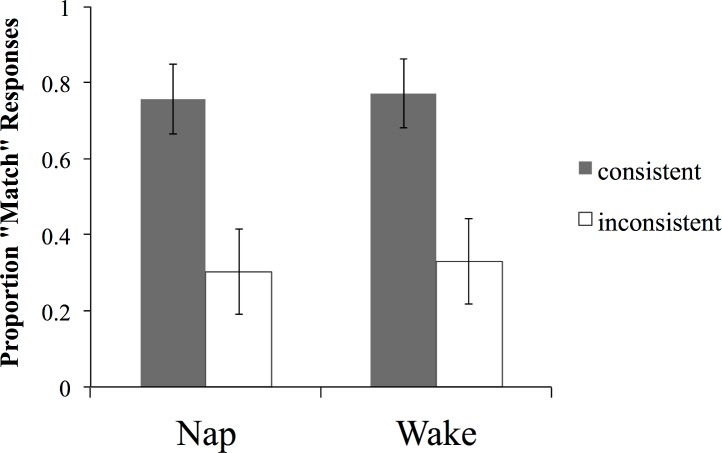
Endorsement rates (proportion of ‘match’ responses) on the word-picture matching task with untrained items for the two groups, for the Determiner + Suffix generalization set.Error bars represent 95% CIs.